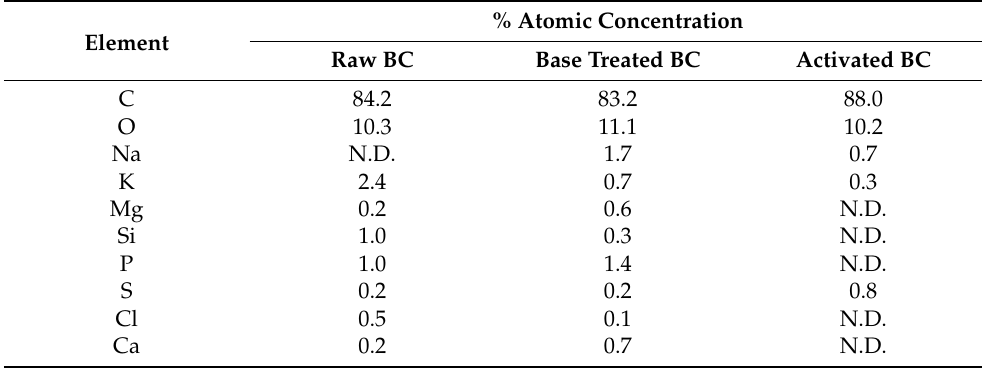
Table 2. % atomic concentration of the different elements of biochars